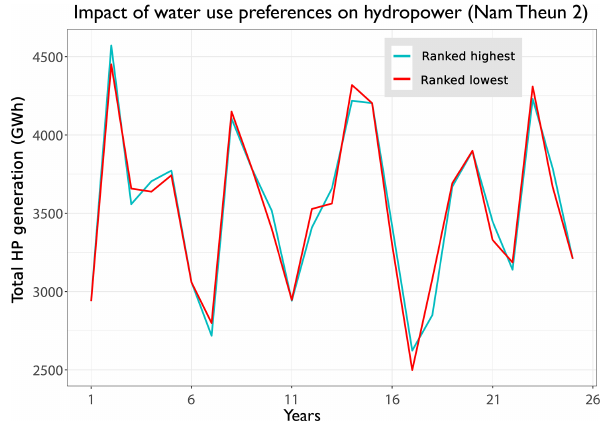
Figure 5. Difference in hydropower generation due to changes in prioritization of hydropower for the Nam Theun 2